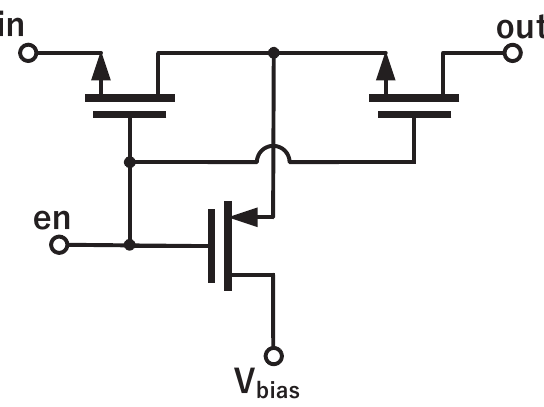
Figure 10. Low-leakage